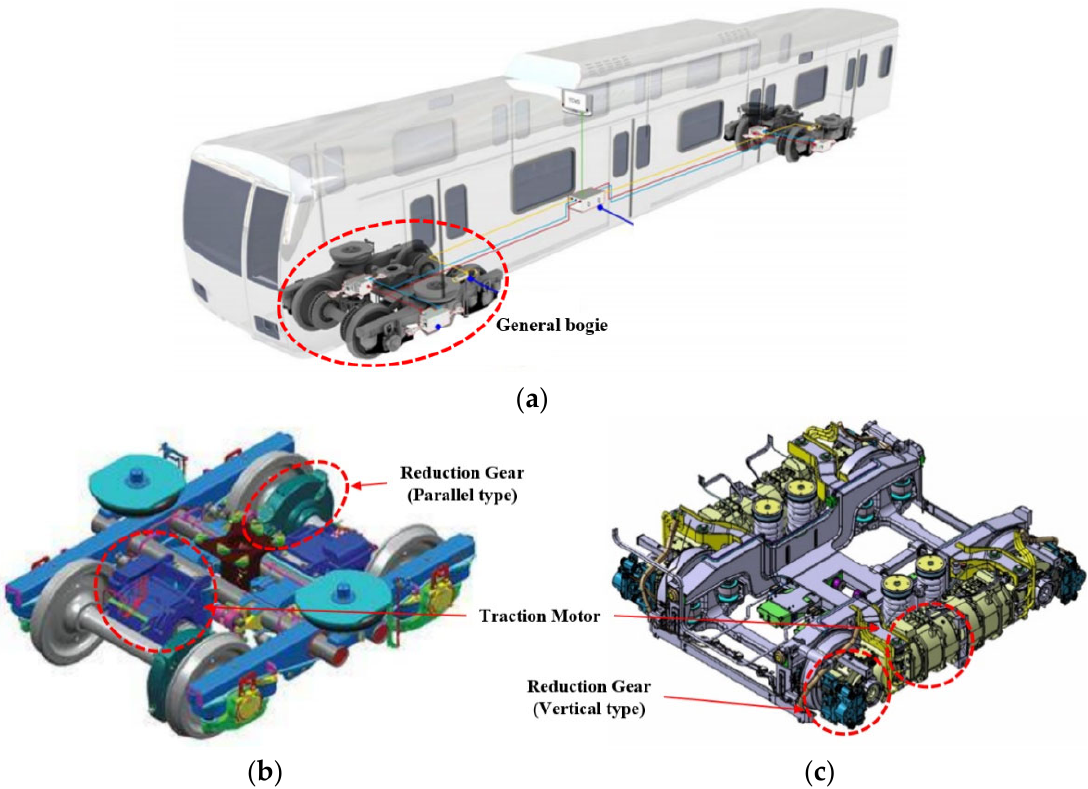
Figure 1. Urban railway vehicle and structure of the bogies according to the type of railway vehicle: ( a ) Urban railway vehicle ( b ) General bogie for railway vehicles; ( c ) Low ‐ floor bogie for tram.